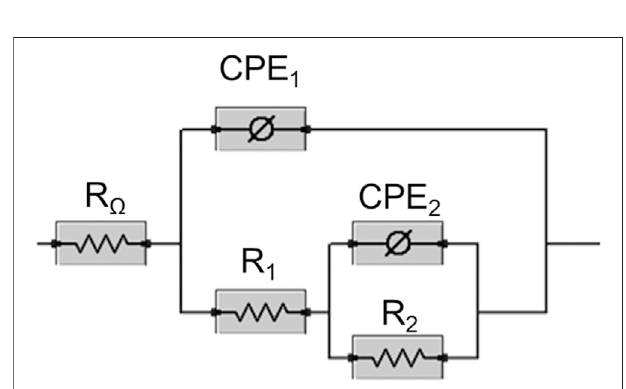
FIGURE 10 | Equivalent circuit used to fi t the experimental